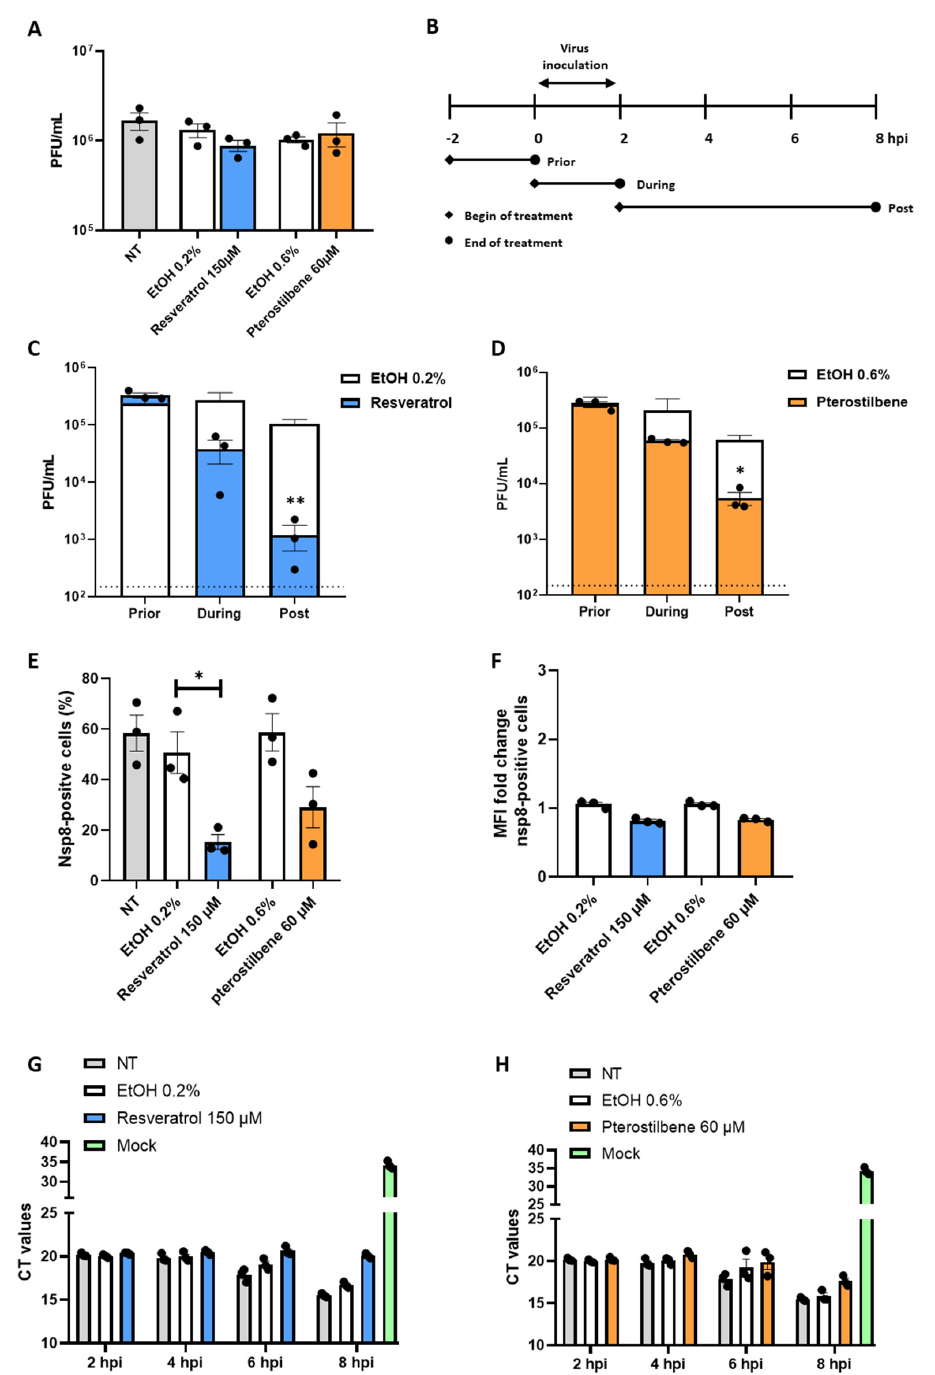
Figure 2. Resveratrol and pterostilbene interfere with SARS-CoV-2 infection when added post virus inoculation conditions. ( A ) Virucidal effect of resveratrol and pterostilbene on SARS-CoV-2. ( B ) Schematic representation of the experimental design of the time-of-drug-addition assay. Vero E6 cells were inoculated with SARS-CoV-2 at MOI 1 and treated with ( C , E , F , G ) 150 µ M resveratrol, ( D , E , F , H ) 60 µ M pterostilbene or ( C – H ) equivalent volumes of EtOH. Virus production was determined at 8 hpi via plaque assay ( C , D ). The number of NSP8-positive cells were determined at 8 hpi via flowcytometry ( E , F ). Intracellular RNA levels were determined at 2,4,6 and 8 hpi via qPCR ( G , H ). Data are represented as mean ± SEM, symbols represent three independent experiments. Dotted line indicates the threshold of detection. Student T test was used to evaluate statistical differences and a p value ≤ 0.05 was considered significant with * p ≤ 0.05. In the absence of ‘*’ the data are